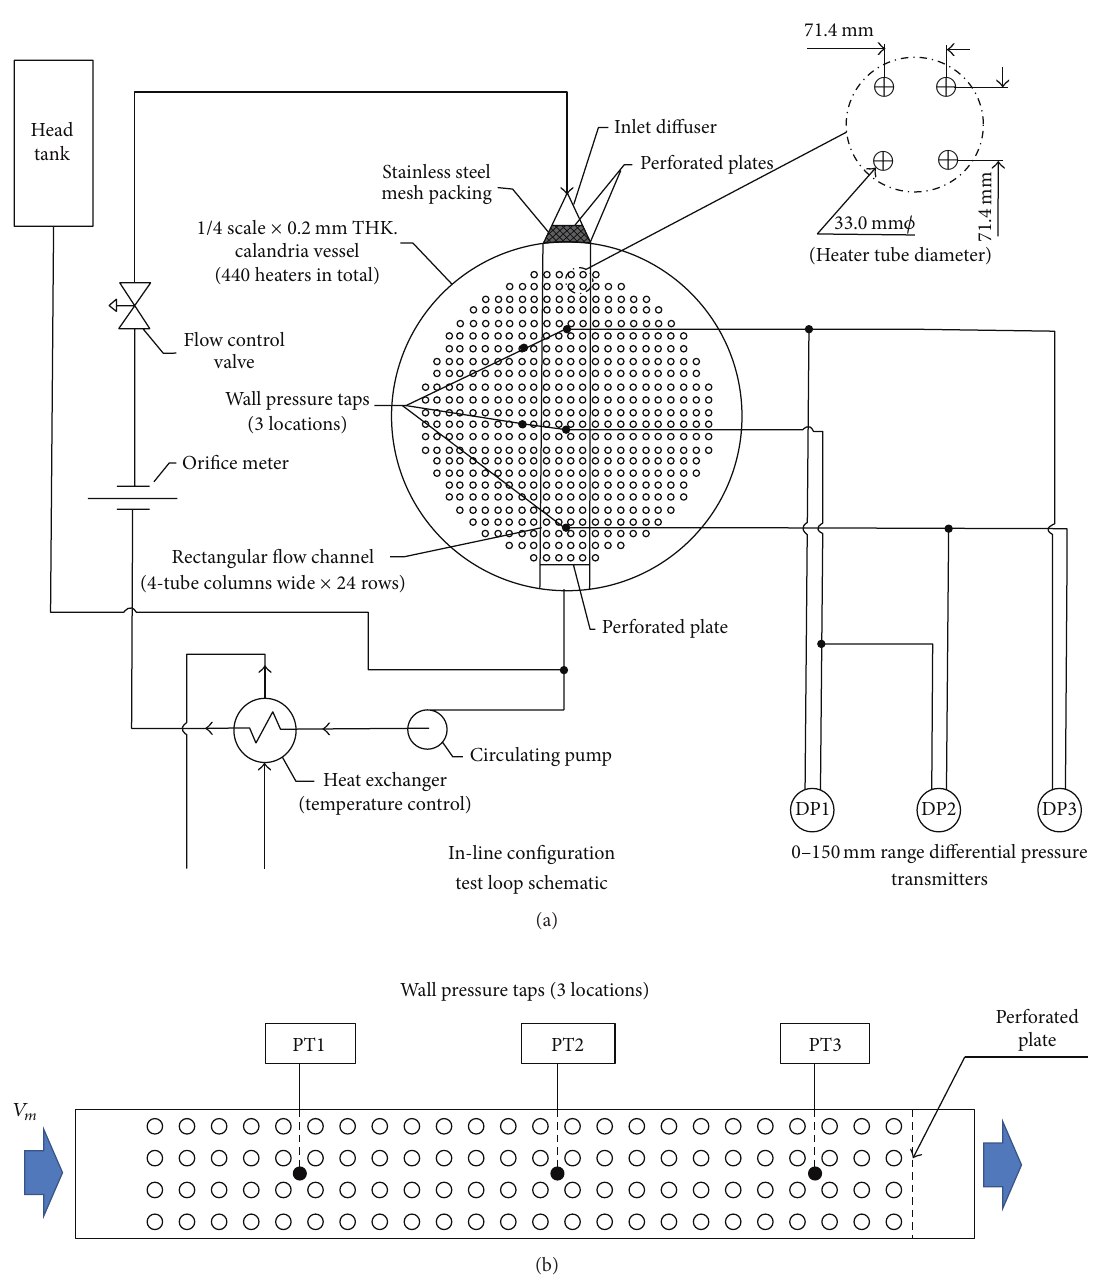
Figure 8: STERN laboratory experiment: (a) experimental configuration and (b) the measurement of pressure [13,